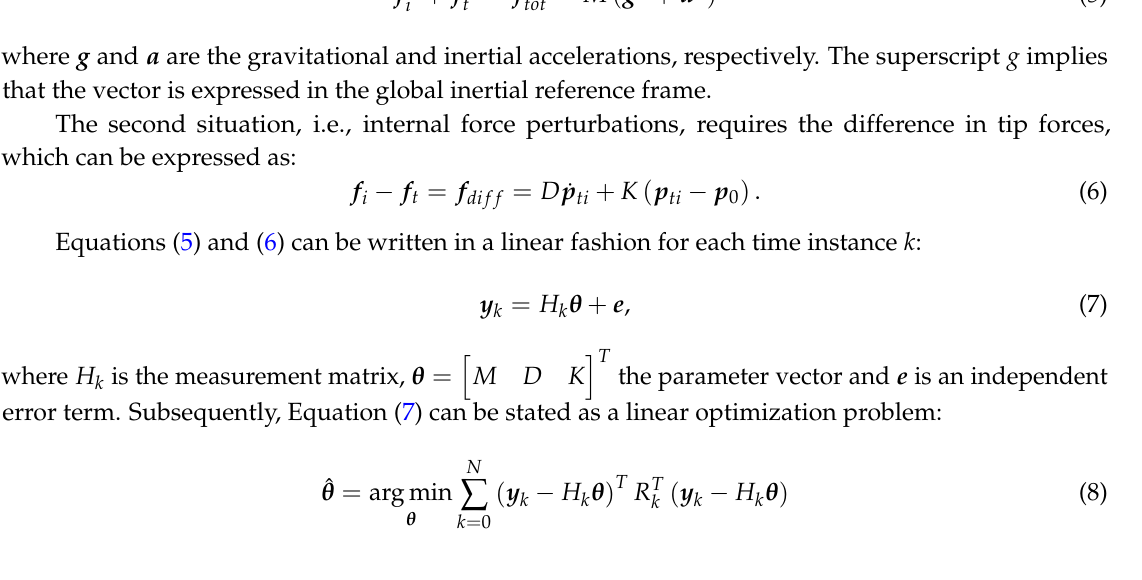
Figure 3. Model of the load configuration grasped by the index finger and thumb. A mass ( M ) is suspended by two spring ( K indicated by f i and f t . The positions of the mass, index finger and thumb are indicated by p m , p i and p t ,